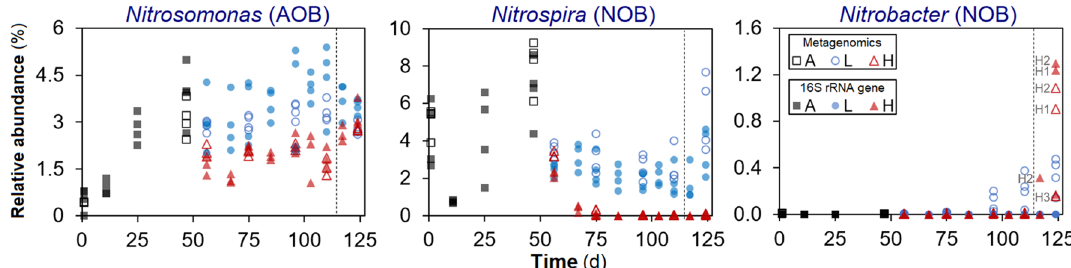
Figure 3. Temporal relative abundance of main nitrifier genera in each reactor. Phases: A, acclimation (n = 4); L, low F:M–C:N (n = 4); H, high F:M–C:N (n = 3). Vertical dashed line indicates the shift from high to low F:M–C:N. Closed symbols display 16S rRNA gene amplicon ASV data and open symbols shotgun metagenomics (summarized reads) data. Left, Nitrosomonas ; centre, Nitrospira ; right, Nitrobacter . There was variable NOB resilience as evident from the increase in Nitrobacter in two (H1 and H2) out of three reactors once the disturbance had been removed.